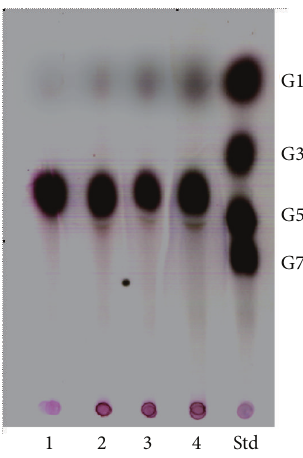
Figure 5: Thin layer chromatography (TLC) of hydrolysis products from 𝛽 -CD generated by CDase-Tk. Lane 1: 1% 𝛽 -CD alone, Lanes 2 to 4: CDase-Tk which was reacted with substrates at 1% concentra- tion at 65 ∘ C for 10, 30, or 60 min. Std indicates the oligosaccharide standard containing 1% glucose, maltotriose, maltopentaose, and